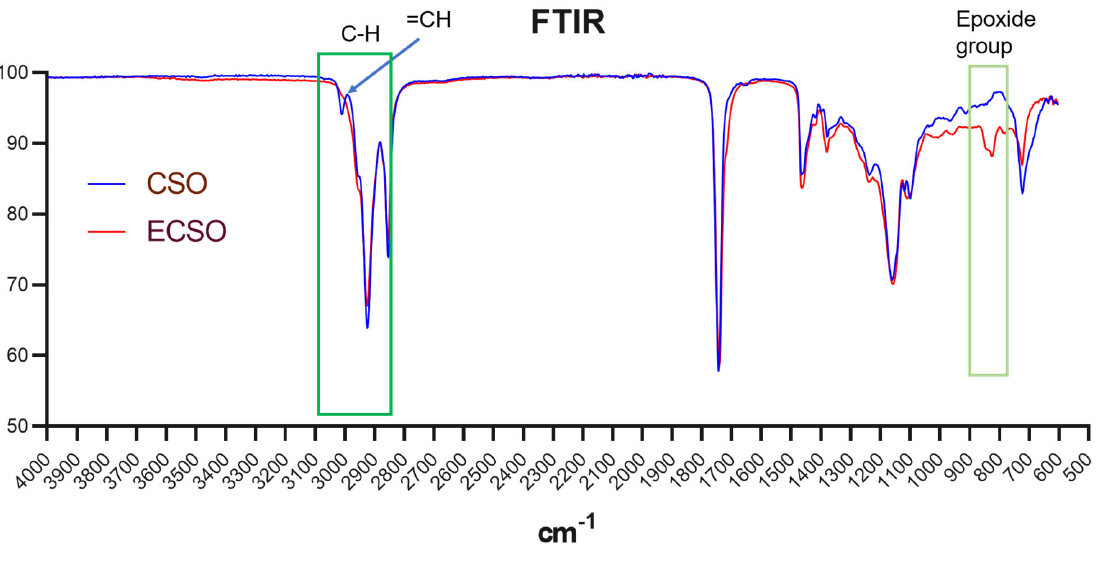
Figure 3. FTIR spectra of CSO (cottonseed oil) and ECSO (epoxidized cottonseed oil).